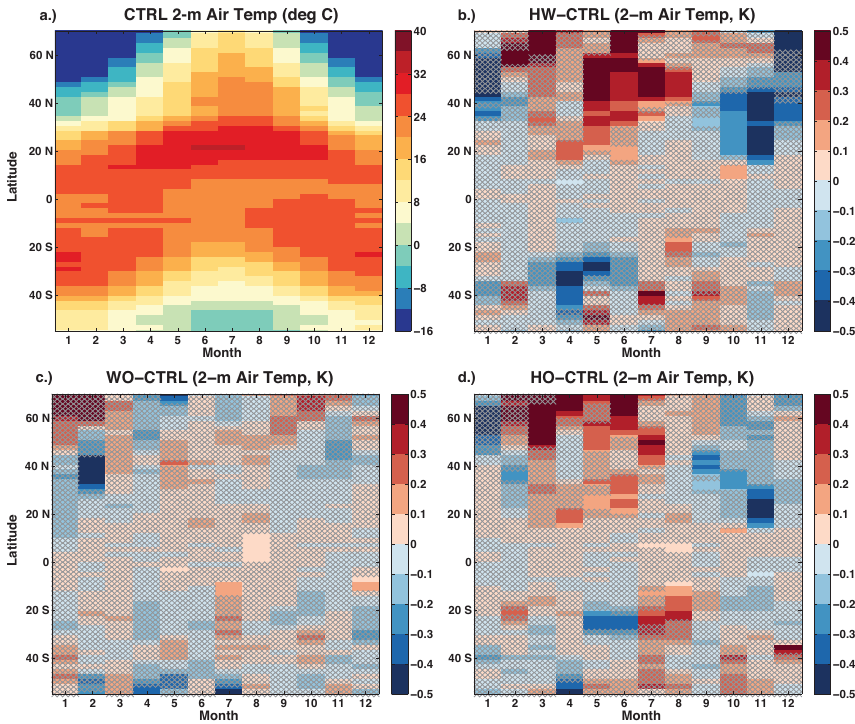
Fig. 2. Month-latitude climatologies of surface air temperature. (a) Control run. (b) Aquifer minus Control run. (c) WaterOnly minus Control run. (d) HeatOnly minus Control run. For (b–d) , differences not significant at the 0.05 level are hatched.